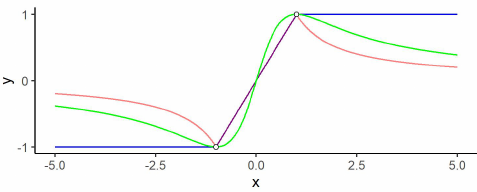
Figure 5. Extension of the function f ( − 1 ) = − 1, f ( 1 ) = 1 using three different methods. In blue, F 1 , the mean of the McShane and Whitney formulas; in red F 2 , the one proposed by Oberman and Milman; and in green, F 3 , our proposal, the 2 − average slope minimizing